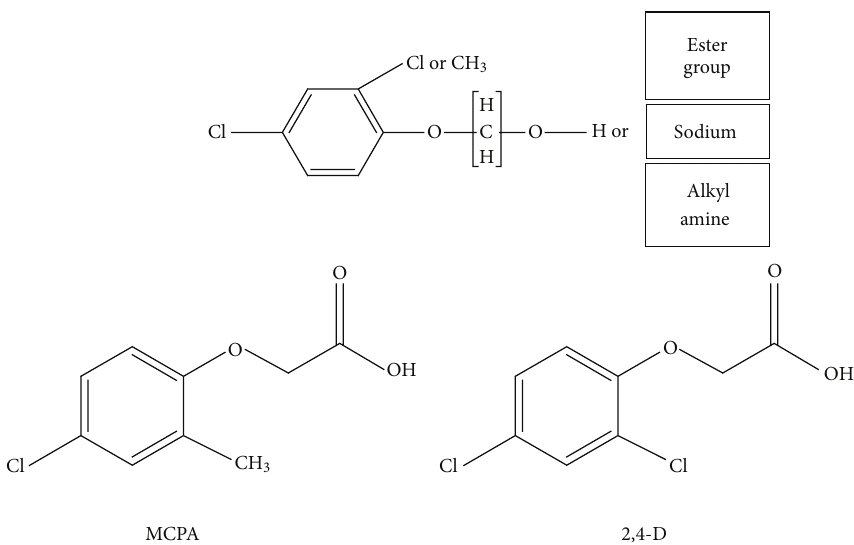
Figure 1: General chemical structure of chlorophenoxy compounds and 2,4-D and MCPA.